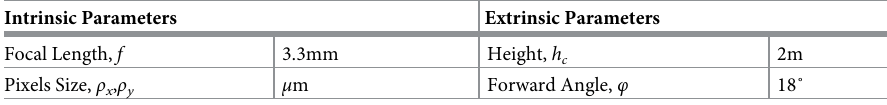
Table 3. Intrinsic and extrinsic parameters of camera.